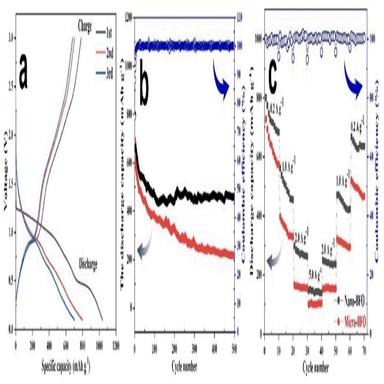
(a) the first three discharge-charge curves for SM-BFO electrode at 0.2 A g−1; SM/micro-BFO electrodes: (b) the cyclic performances at 0.2 A g−1 and (c) rate capabilities.